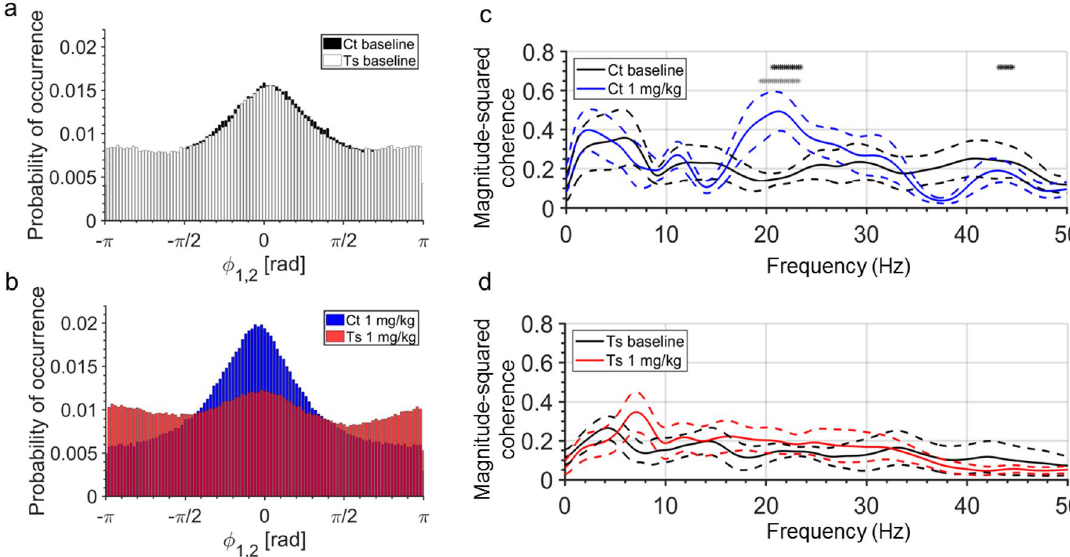
Figure 3. Diazepam-treated Ts65Dn mice show genotype-dependent differences in neural synchrony. ( a , b ) Histograms of phase differences between cortical and hippocampal EEG recordings, which were computed by dividing the phase-spectrum (0–360°) into equal-sized 100 bins (3.6°/bin). ( a ) Control and Ts65Dn mice showed similar phase-lag distributions during baseline recordings. ( b ) Diazepam at 1-mg/kg dose narrowed the peak of phase-difference distribution in control mice as the number of phase-lag estimates close to zero increased, whereas phase lag distribution of diazepam-treated Ts65Dn mice exhibited an almost uniform distribution. ( c ) Diazepam-treated control mice showed an increase in the pairwise coherence in the beta-2 frequency range (19.40–23.20 Hz; grey asterisks) compared to their pre-injection baseline. ( d ) Diazepam-treated Ts65Dn mice showed no significant changes in coherent activity compared to their pre-injection baseline. Significant differences in pairwise coherence at 20.60–23.40 Hz and 43.20–44.60 Hz frequency ranges were detected between diazepam-treated control and Ts65Dn mice (black asterisks in c ). Number of mice: Ct baseline (N = 6), Ct 1 mg/kg diazepam (N = 6), Ts baseline (N = 7), and Ts 1 mg/kg diazepam (N =